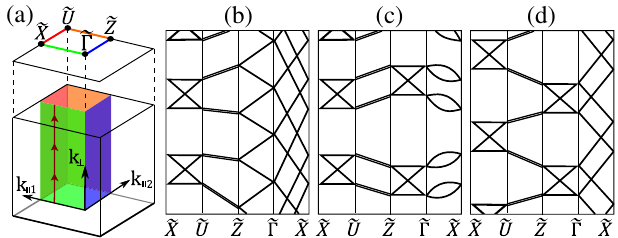
FIG. 1. (a) Mirror (red, blue) and glide (green, brown) planes in the 3D Brillouin torus of KHg X . These planes project to the high- ~ X ~ U ~ Z ~ Γ ~ X symmetry line in the 2D Brillouin torus of the 010 surface. (b) – (d) Examples of possible piecewise topologies in the space group of KHg X , as illustrated by their surface band ~ X ~ U ~ Z ~ Γ ~ X structures along . Panel (b) describes a “ quantum glide ~ Z ~ Γ Hall effect ” (along ) and an odd mirror-Chern number (along ~ Γ ~ X ); these two subtopologies must be pieced together at their ~ Γ intersection point . Panel (c) describes an hourglass-flow top- ~ Γ ~ ~ X ~ U ~ Z ~ Γ X ). (d) A ology ( ) and an even mirror-Chern number ( trivial topology is shown for